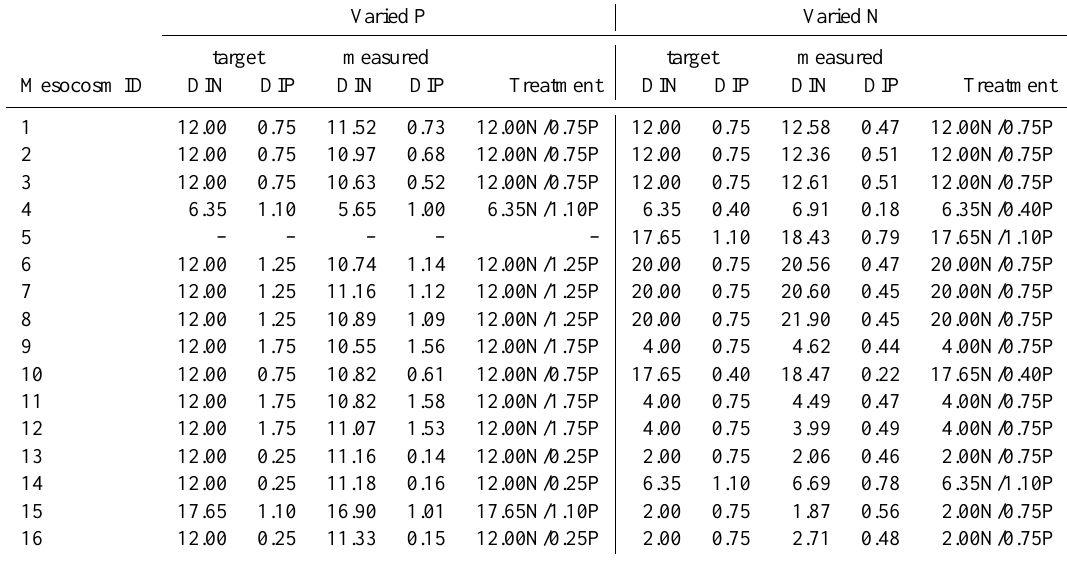
Table 1. Varied P and Varied N: target and measured concentrations of DIN and DIP and treatment identifications according to target values. Varied P Varied N target measured target measured Mesocosm ID